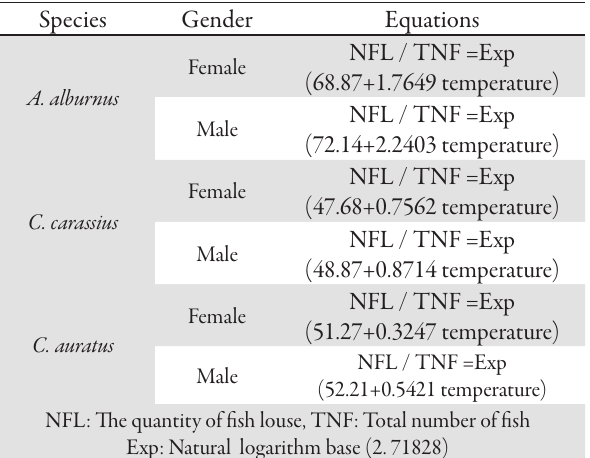
Tab. 2. Regression equations obtained from Poisson regression analysis